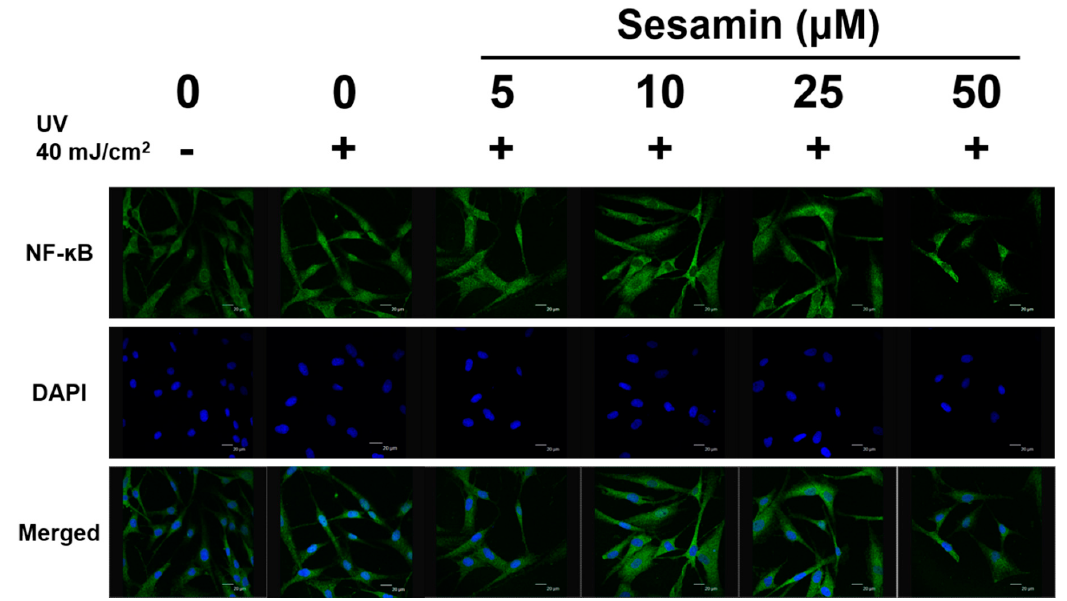
Figure 11. Effect of sesamin on the UVB-induced activation of nuclear factor κ B p65 in human skin fibroblasts.